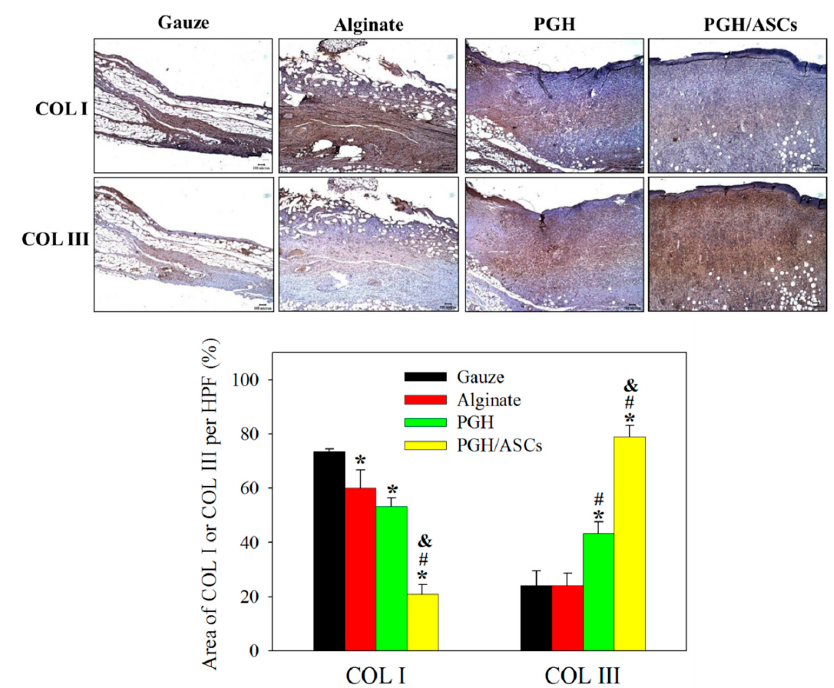
Figure 11. The representative immunohistochemical (IHC) staining images of type 1 collagen (COL I) and type 3 collagen (COL III) (bar = 100 µ m) in wound tissues of SD rats after treatment with gauze, alginate wound dressing, PGH, or PCH/ASCs for 14 days, and the area percentage of COL I and COL III per high-power field (HPF) ( n = 4). * p < 0.05 compared with gauze; # p < 0.05 compared with alginate; & p < 0.05 compared with PGH.